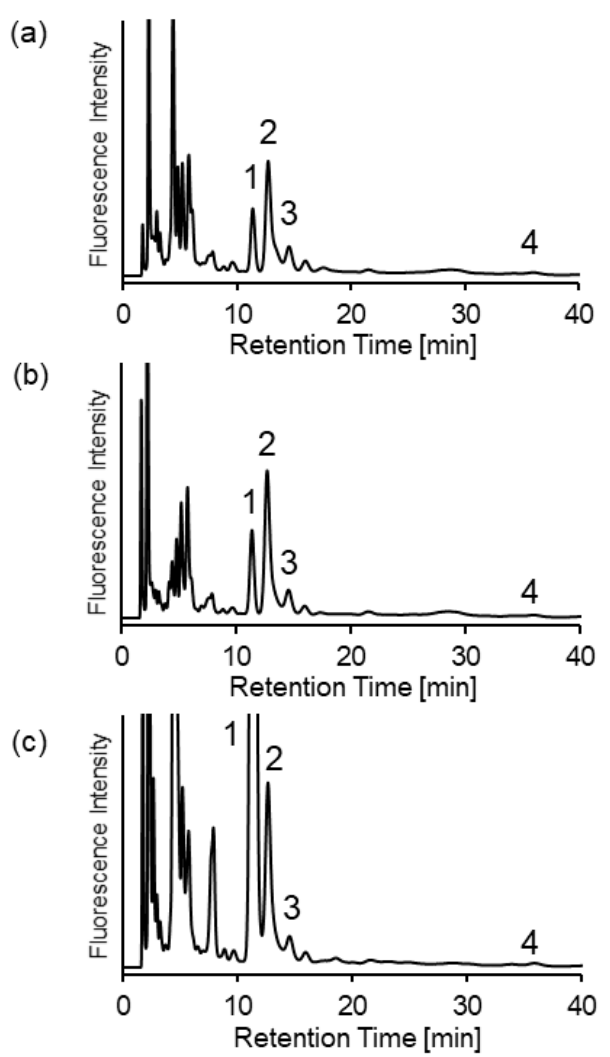
Figure 5. Chromatograms of ( a ) CBS-wild type (CBS-WT), ( b ) CBS-heterozygous (CBS-Hetero), and ( c ) CBS-knockout (CBS-KO) mouse urine samples. Mobile phase—acetonitrile/120 mM ammonium formate (pH 3.0) (81:19). Peaks—1, SBD-Hcy; 2, SBD-Cys; 3, SBD-CysGly; 4, SBD-GSH.